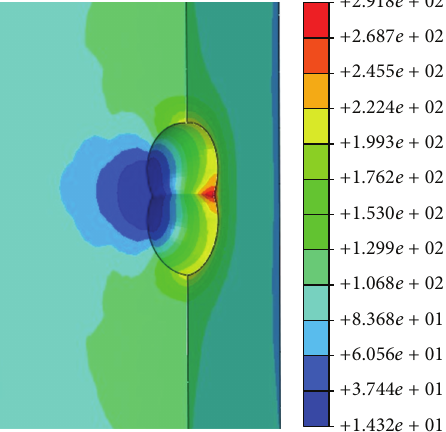
Figure 6: Cross section stress distribution of single cavity ( 𝐿/𝑅 = 1.0 ).